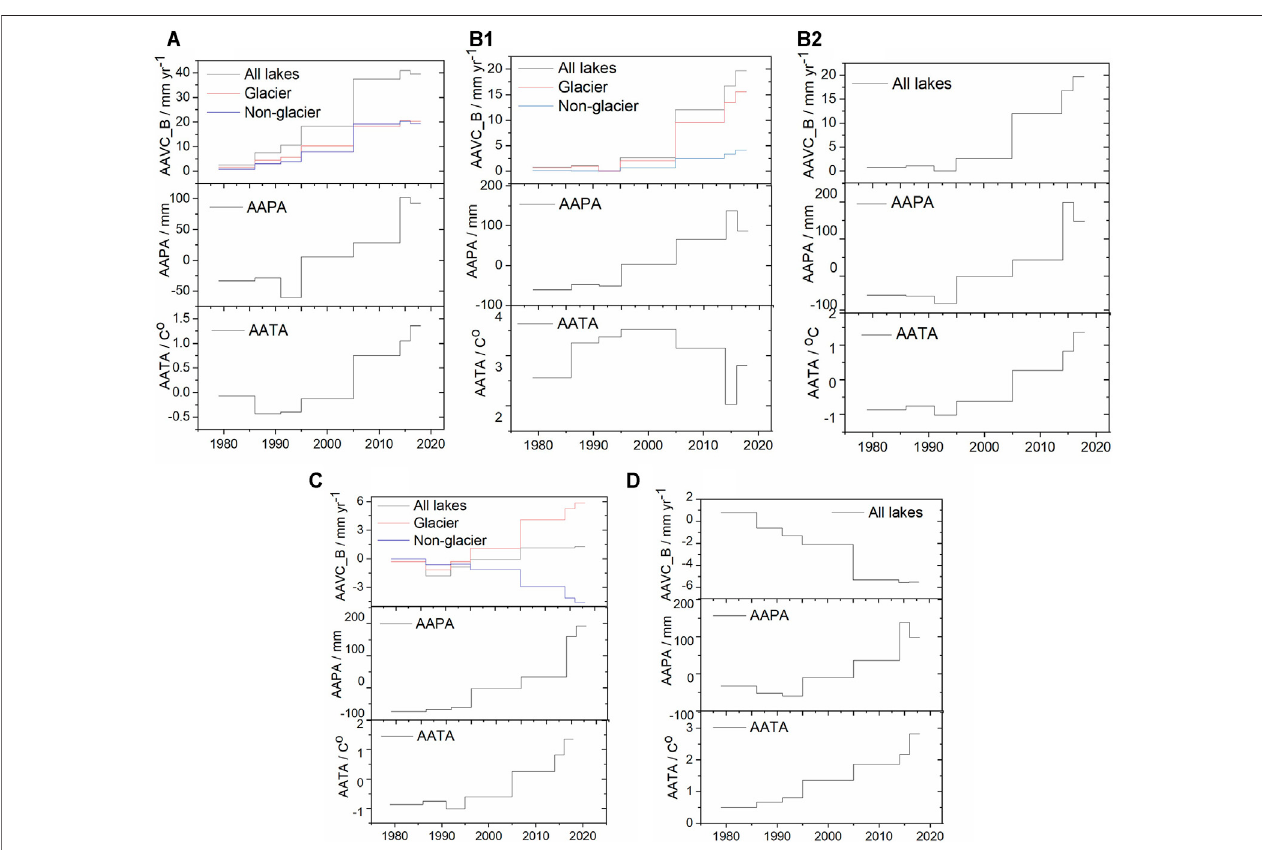
FIGURE 7 | Changes in AAVC_B, AAPA and AATA during different periods and in different regions.